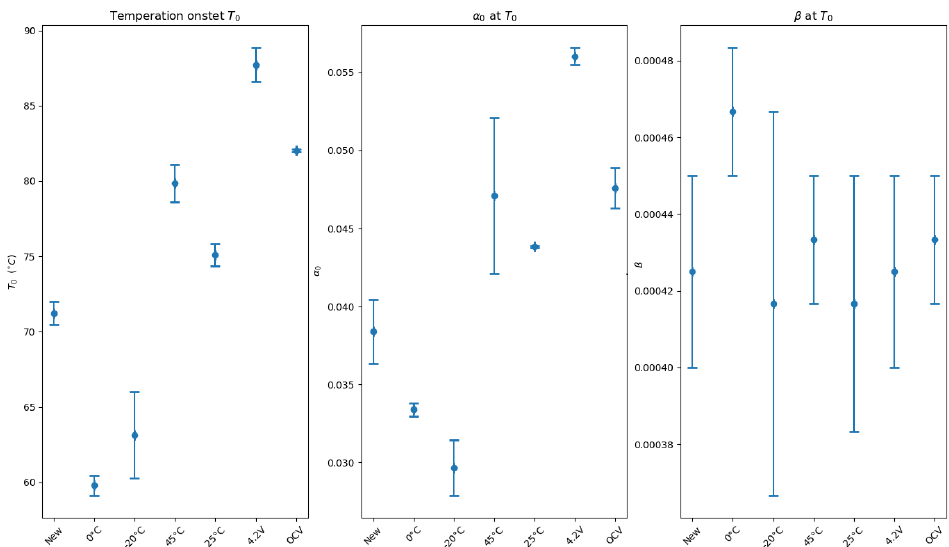
Figure 7. Onset temperature for different ageing conditions (new/fresh, 0 ◦ C, − 20 ◦ C, 45 ◦ C, 25 ◦ C, at constant voltage (calendar ageing) at 4.2 V and OCV after charge at 4.2 V at room temperature). Fractional degree of conversion ( α 0 ) of reactants at t 0 and temperature rate ( β 0 ) at t 0 .